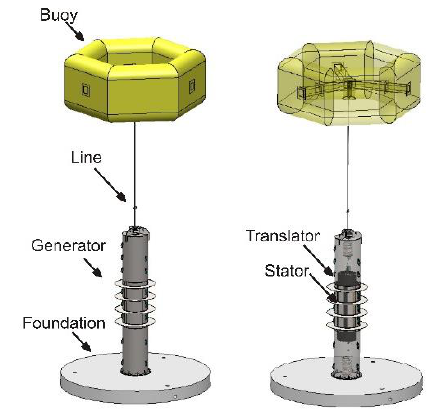
Figure 1. Overall illustration of the linear generator the paper focus on. Table 1. The main dimensions of the generator.